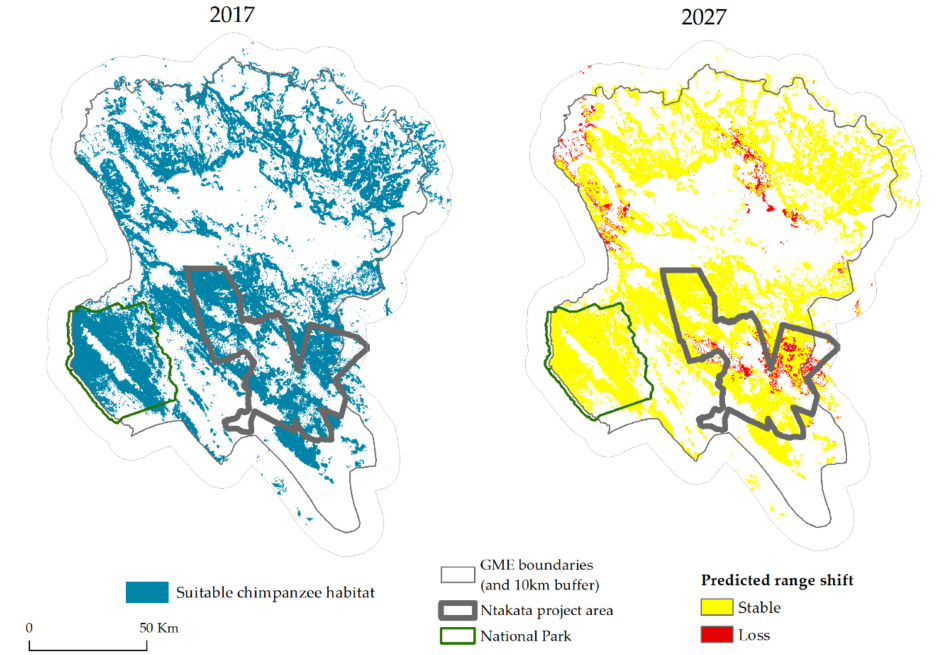
Figure 3. Habitat suitability maps for 2017 and 2027 within the Greater Mahale Ecosystem (GME). All maps in projection WGS84 UTM Zone